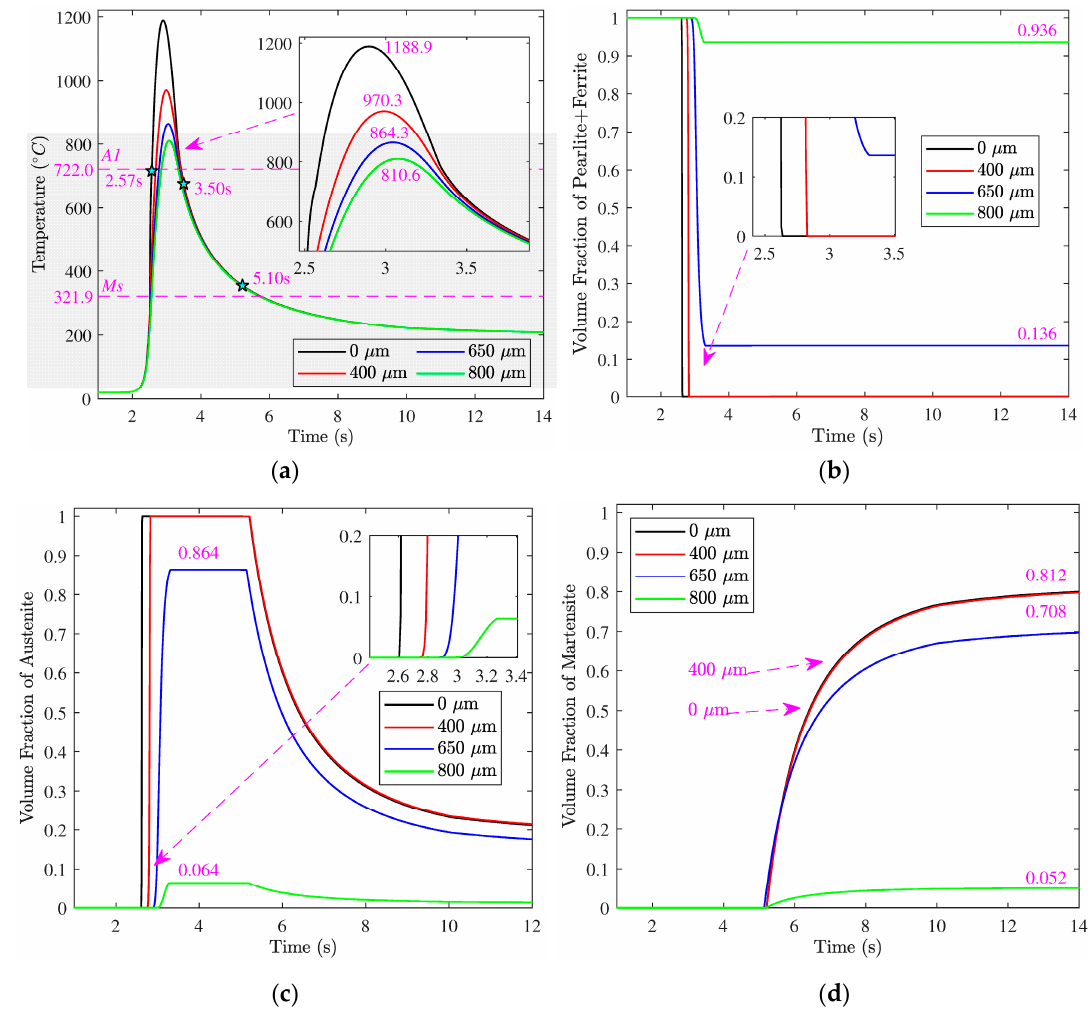
Figure 9. Evolution of temperature and each phase at different depths: ( a ) temperature; ( b ) ferrite + pearlite; ( c ) austenite; ( d ) martensite.